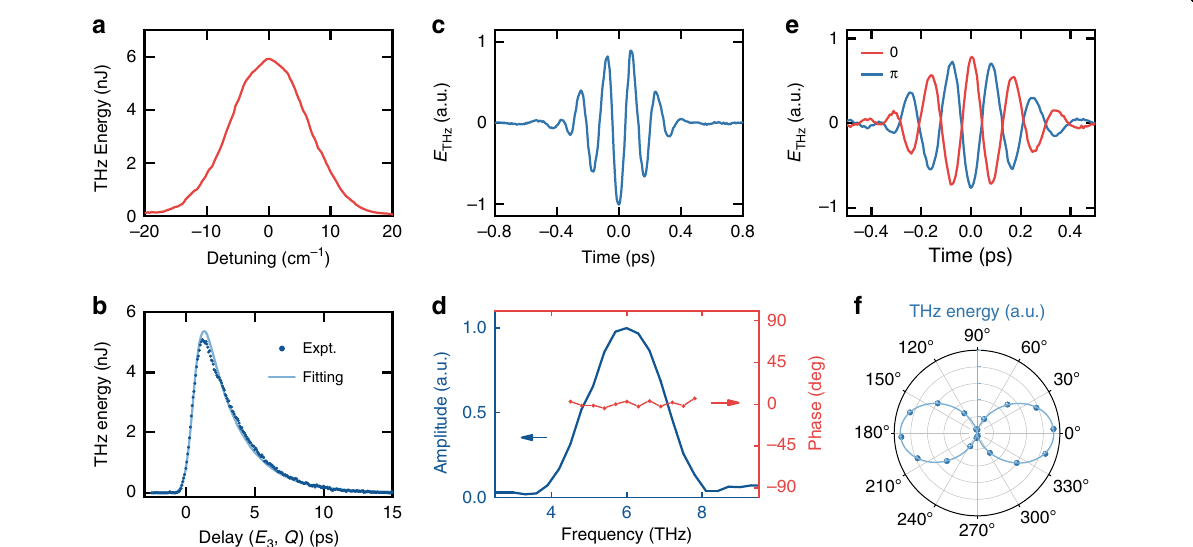
Fig. 3 Characteristics of THz generation by R-FWM in diamond. a THz output energy versus resonance detuning. b Dependence of THz output energy with time relative to the vibration excitation Q ( t ) and its fi t with | Q ( t )| 2 . c Temporal trace of a THz pulse with PM at 5 THz measured by EOS in GaP. d Amplitude and phase spectra from Fourier transform of the THz pulse in ( c ). e THz pulses with CEP of 0 (red curve) and π (blue curve). f Measurement (scatters) and fi tting (solid curve) of polarization distribution of 17 THz output showing that the THz pulses were linearly